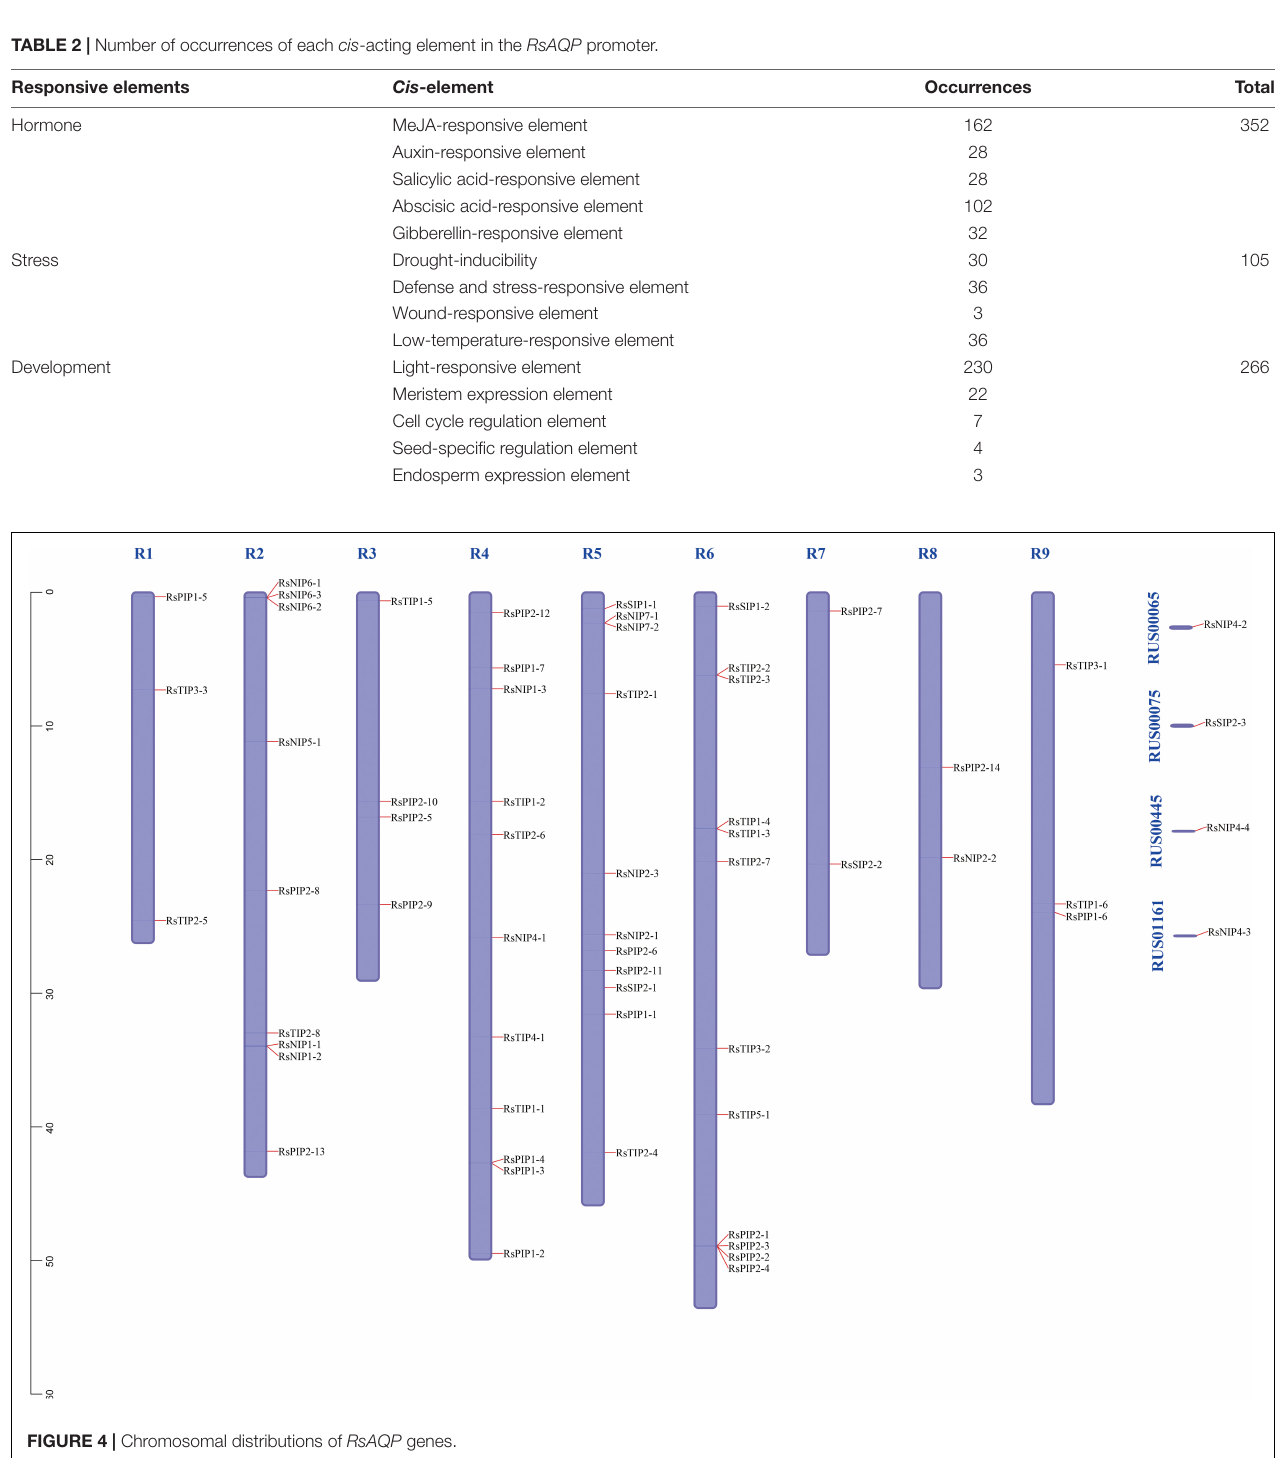
FIGURE 4 | Chromosomal distributions of RsAQP